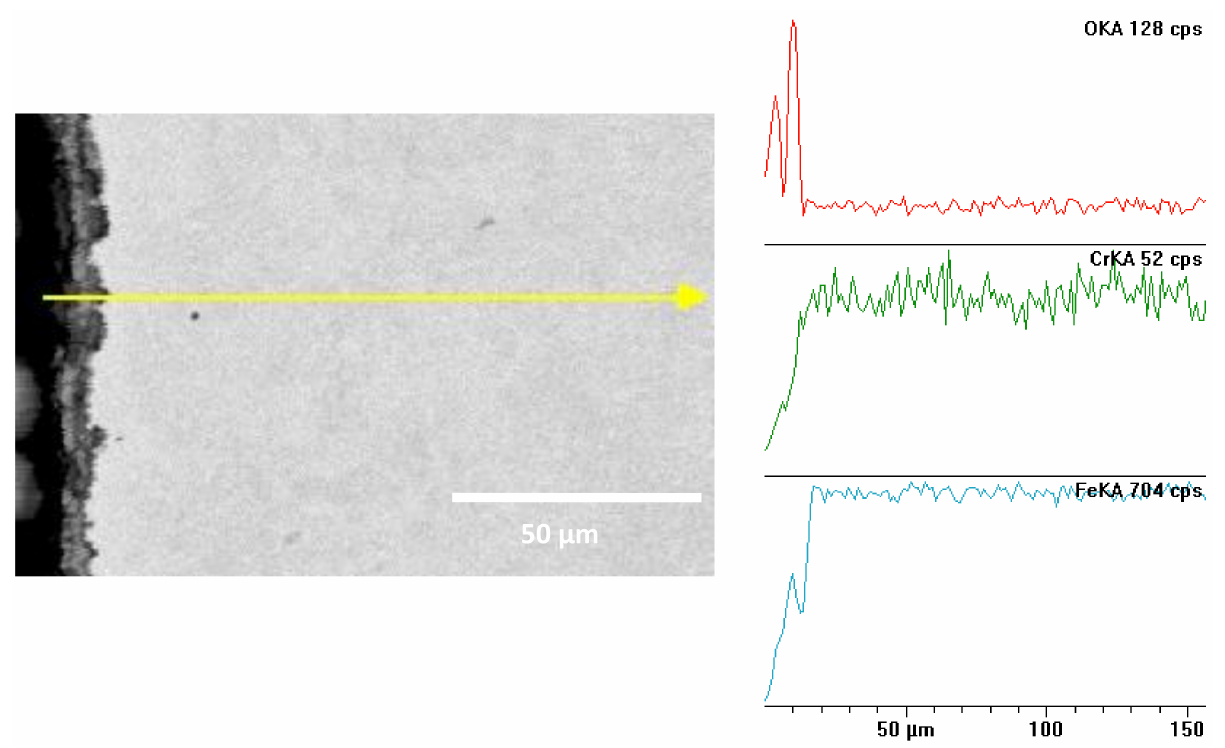
Figure 13. Cross section and linear cross scan of the elements in L80-1 steel at 65 ◦